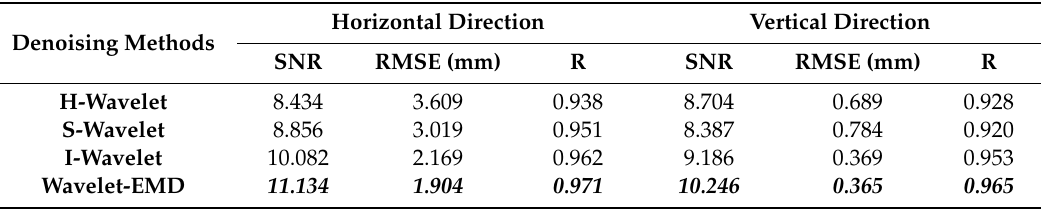
Table 3. Results of the four denoising methods in the horizontal and vertical directions.